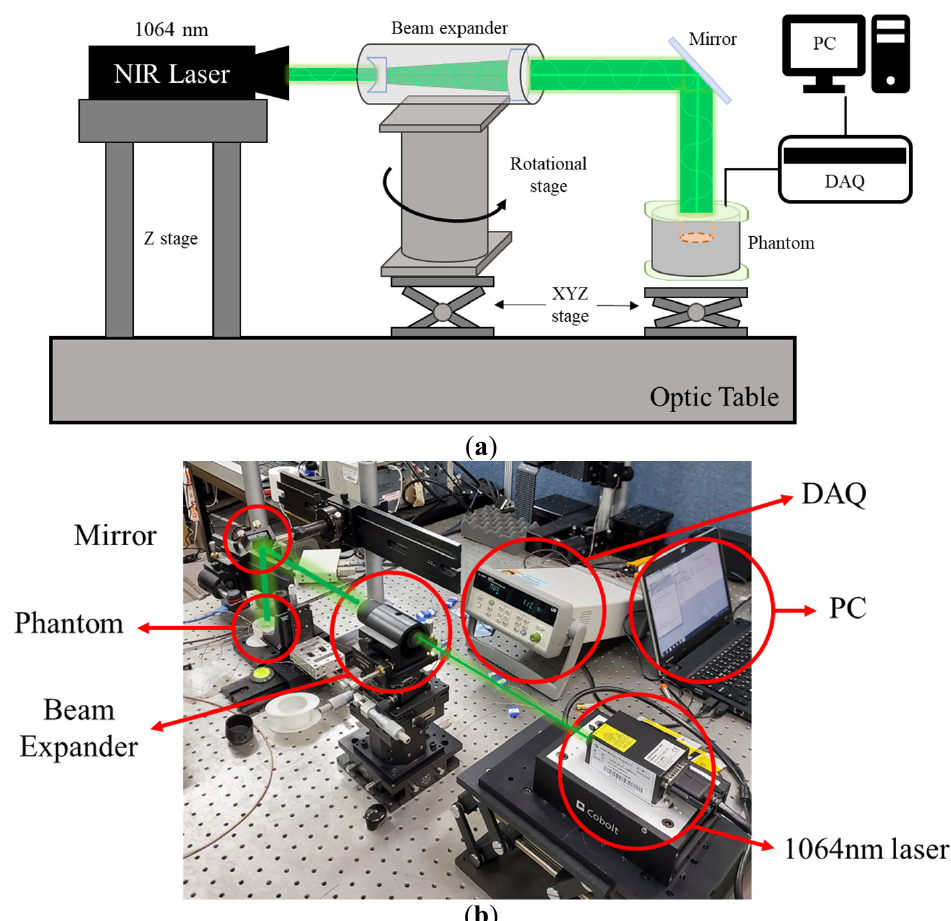
Figure 3. ( a ) Schematic of experiment apparatus; ( b ) photograph of experiment apparatus.